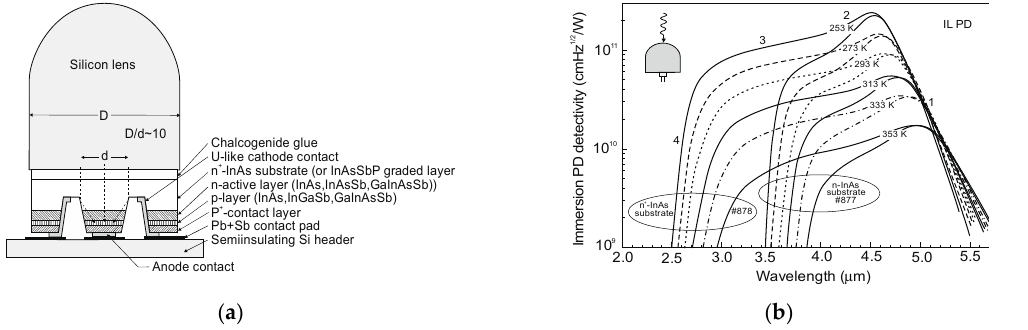
Figure 38. DH InAsSb immersion photodiodes: ( a ) construction of the immersion photodiode (after [121]) and ( b ) detectivity spectra at different temperatures for InAsSb photodiodes with n-InAs and n + -InAs substrates (after [123]).